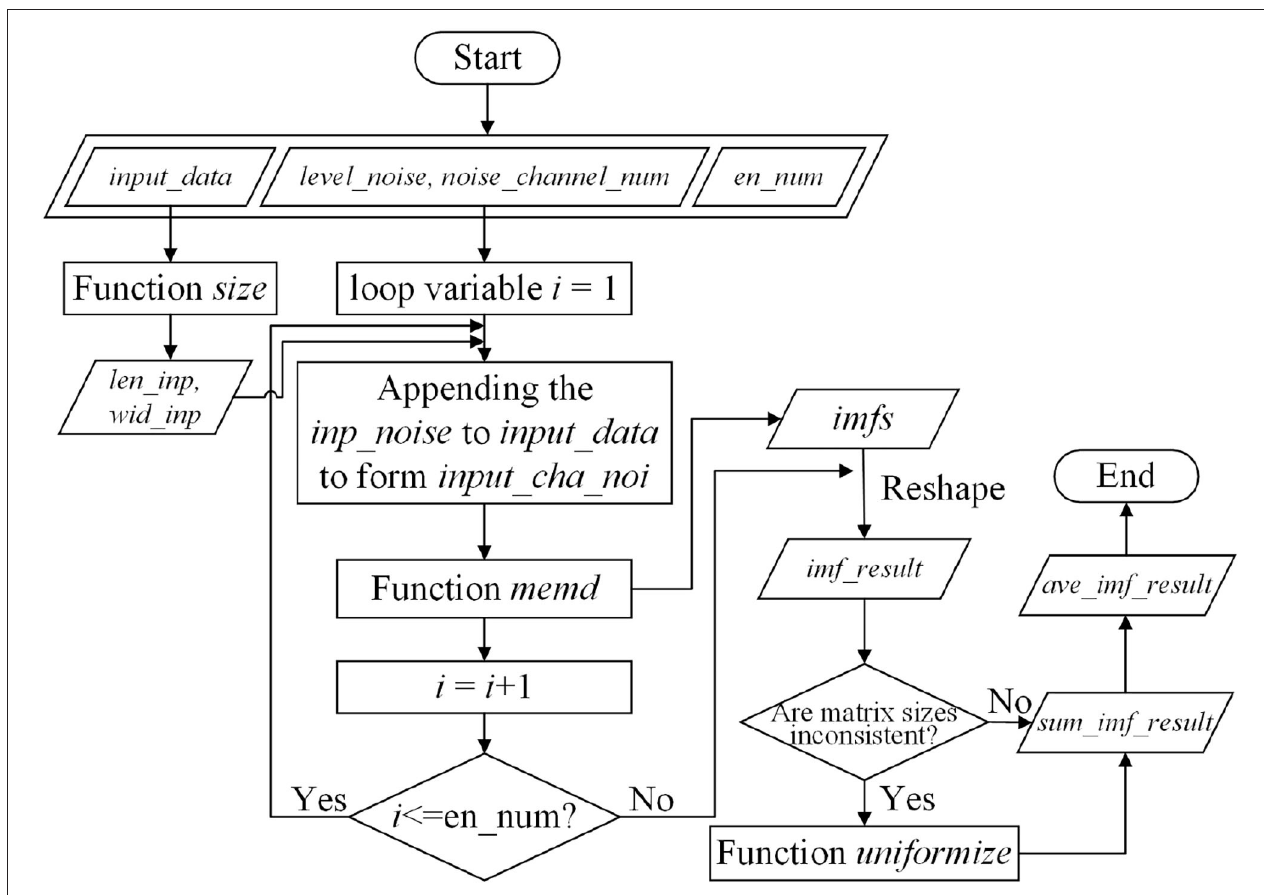
FIGURE 2 | The workflow of function na _ memd